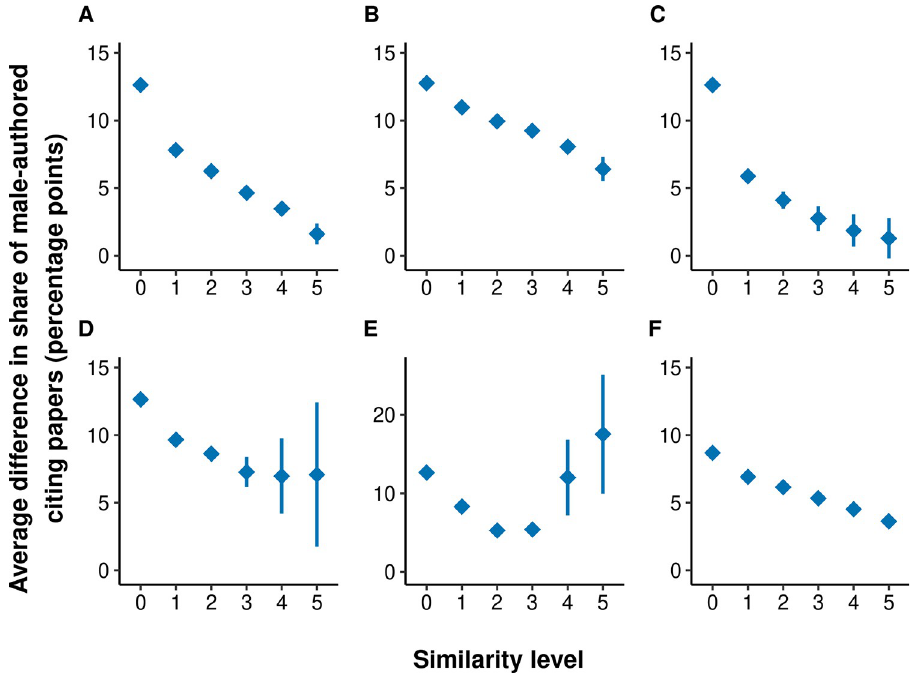
Fig 5. Results for alternative approaches to measure similarity. Average differences in the share of male-authored citing papers across different similarity levels. Bars show 95% confidence intervals. (A)-(E) are based on Faculty Opinions data, (F) on WoS data. The similarity between focal papers is measured using the number of shared keywords provided by the Faculty Opinions database in (A), abstracts and titles in (B) and (F), cited references in